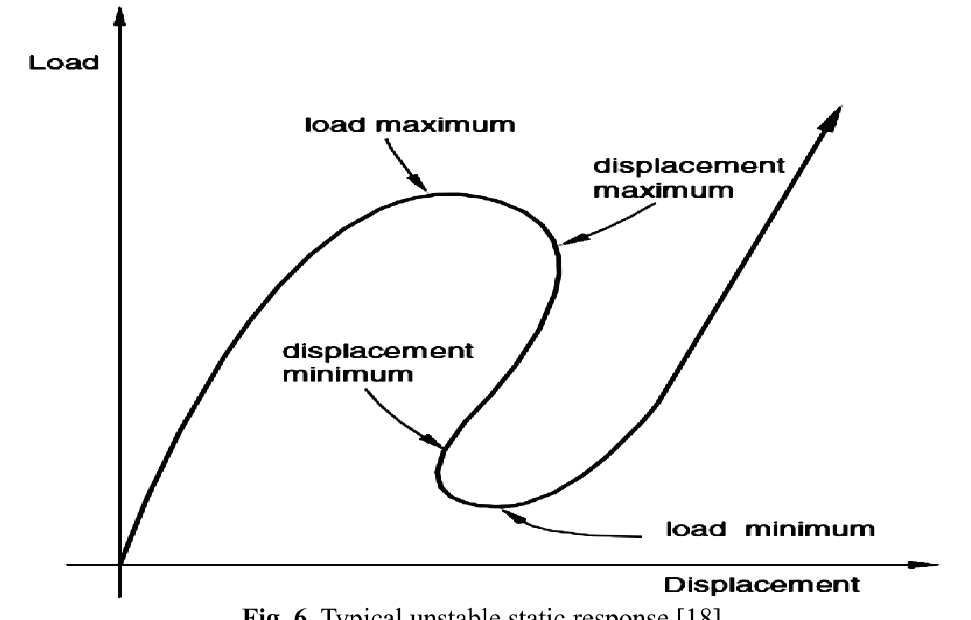
Fig. 6. Typical unstable static response